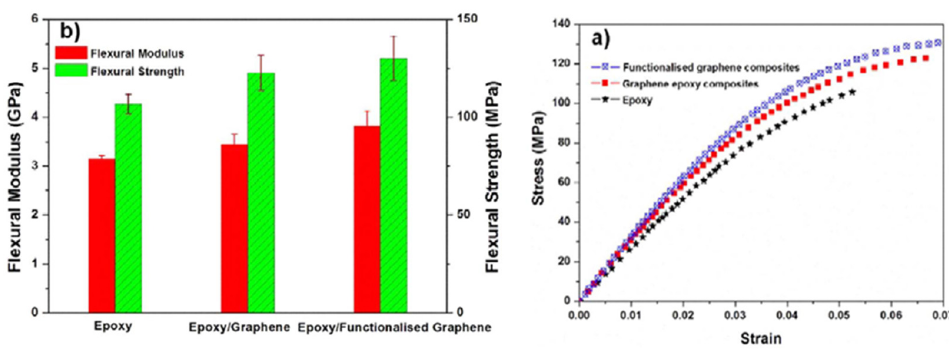
Figure 19. ( a ) Stress–strain diagrams; ( b ) bending modulus and strength of the composite samples. Reproduced from [213] (CC BY).